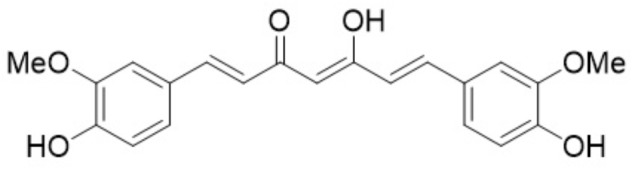
Curcumin formula.